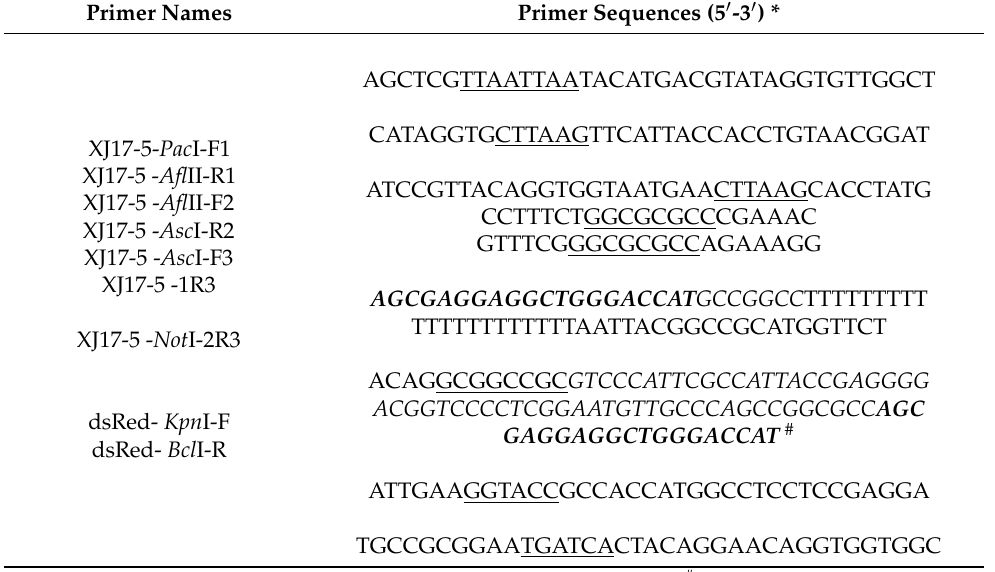
Table 1. PCR primers used for the construction of PRRSV XJ17-5 infectious